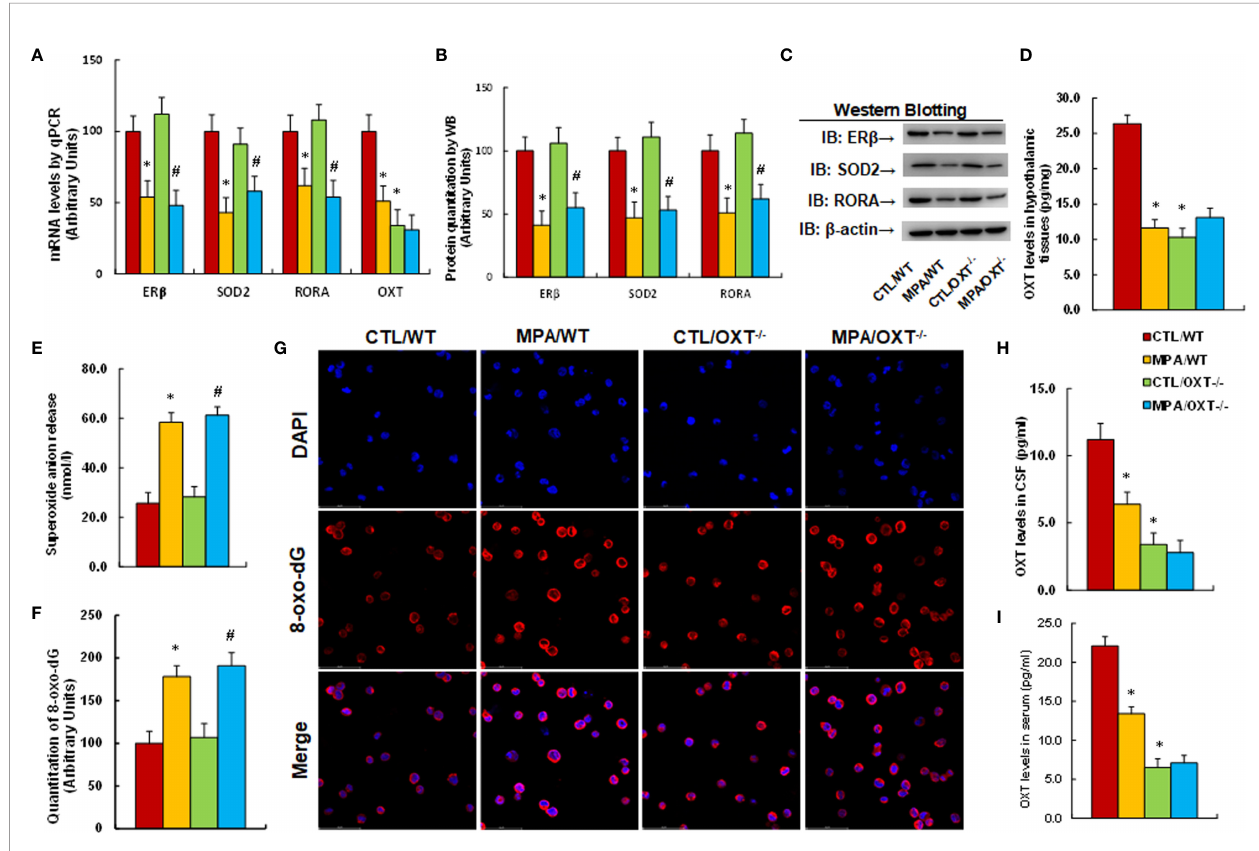
FIGURE 3 | Prenatal OXT de fi ciency mimics prenatal MPA exposure-mediated OXT suppression and oxidative stress. The OXT wild type (WT) or OXT null (OXT -/- ) background dams were treated by either control (CTL) or MPA and the hypothalamic neurons or tissues from PVN area of offspring were isolated for biological assays. (A-D) The hypothalamic tissues were isolated for analysis. (A) mRNA levels, n=4. (B) Protein quantitation, n=5. (C) Representative western blots for (B) . (D) OXT levels in hypothalamic tissues, n=5. (E) Superoxide anion release in hypothalamic tissues, n=5. (F, G) Immunostaining of hypothalamic neurons. (F) 8- oxo-dG staining quantitation, n=5. (G) Representative 8-oxo-dG staining (red) and DAPI staining (blue). (H) OXT levels in CSF, n=5. (I) OXT levels in serum, n=5. * P < 0.05, vs. CTL/WT group; # P < 0.05, vs. CTL/OXT-/- group. Data were expressed as mean ±